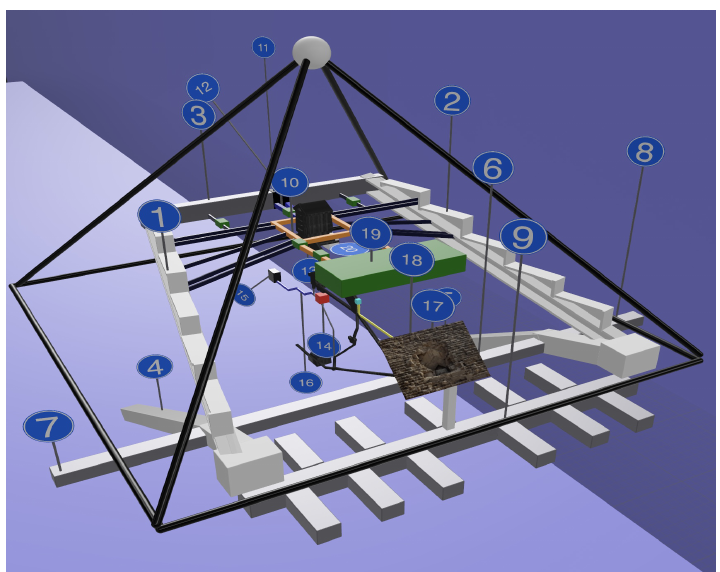
Figure 22. Three-dimensional (3D) reconstruction of the pyramid of Khnum-Khufu downstream of the interpretation of tomograms estimated through radar